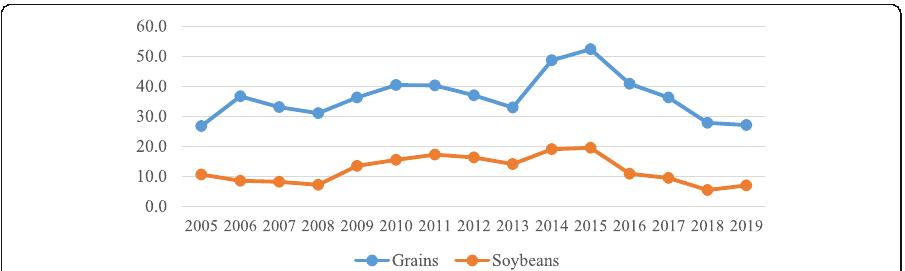
Fig. 1 Grain and Soybeans Flows through the Panama Canal. Millions of Long Tons. Source: Panama Canal internal